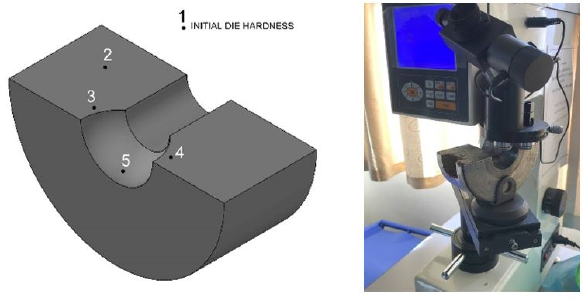
Figure 2: Illustration of die hardness